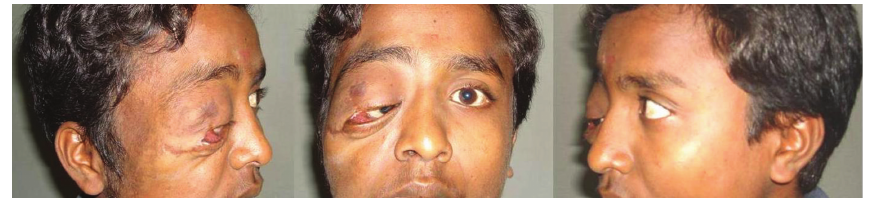
Figure 1: Clinical picture of the patient showing plexiform neurofibromatosis.